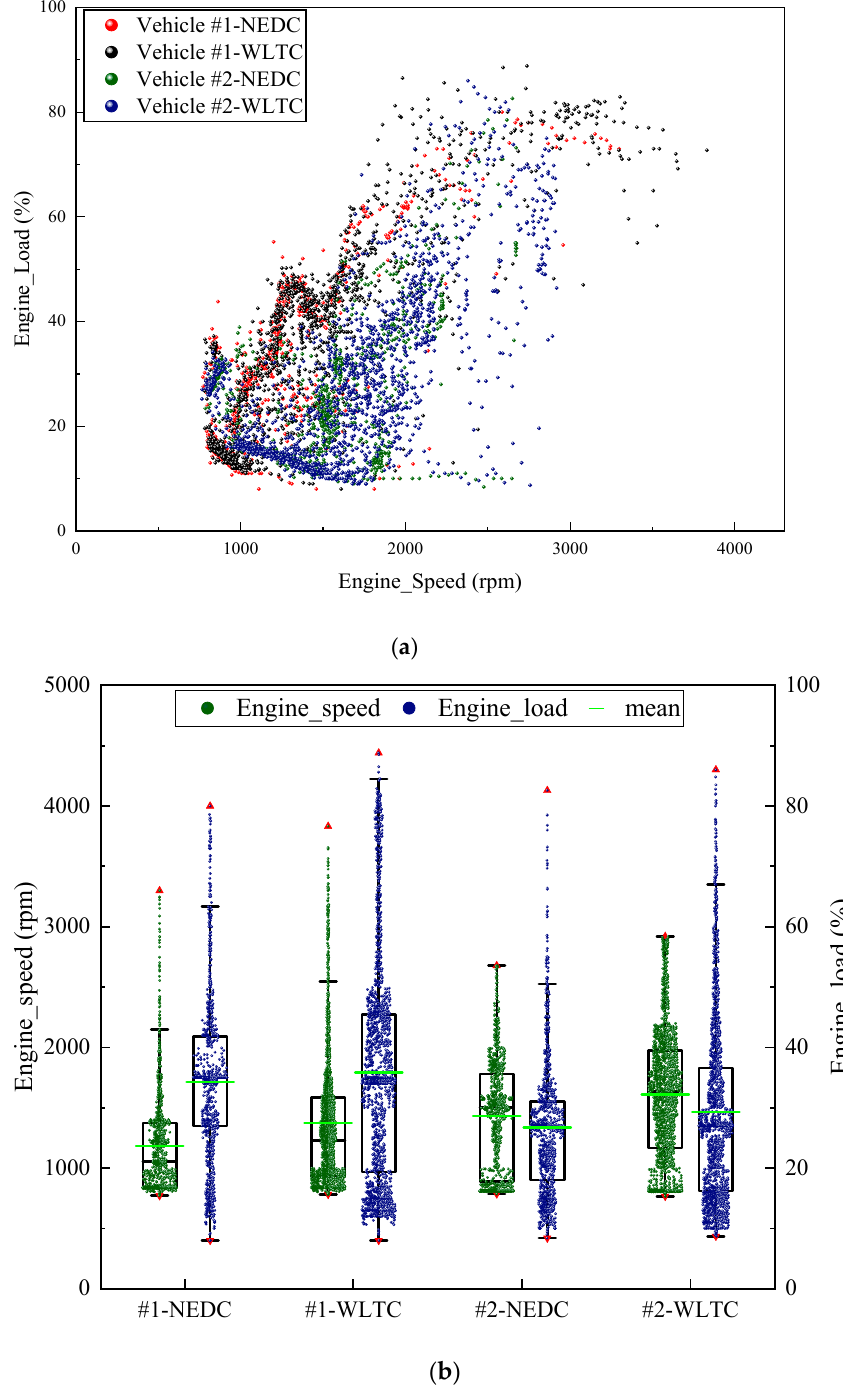
Figure 1. Engine speed vs. load distribution of the two test vehicles: ( a ) distributions of engine speed and load; ( b ) statistical distributions of engine speed and load.